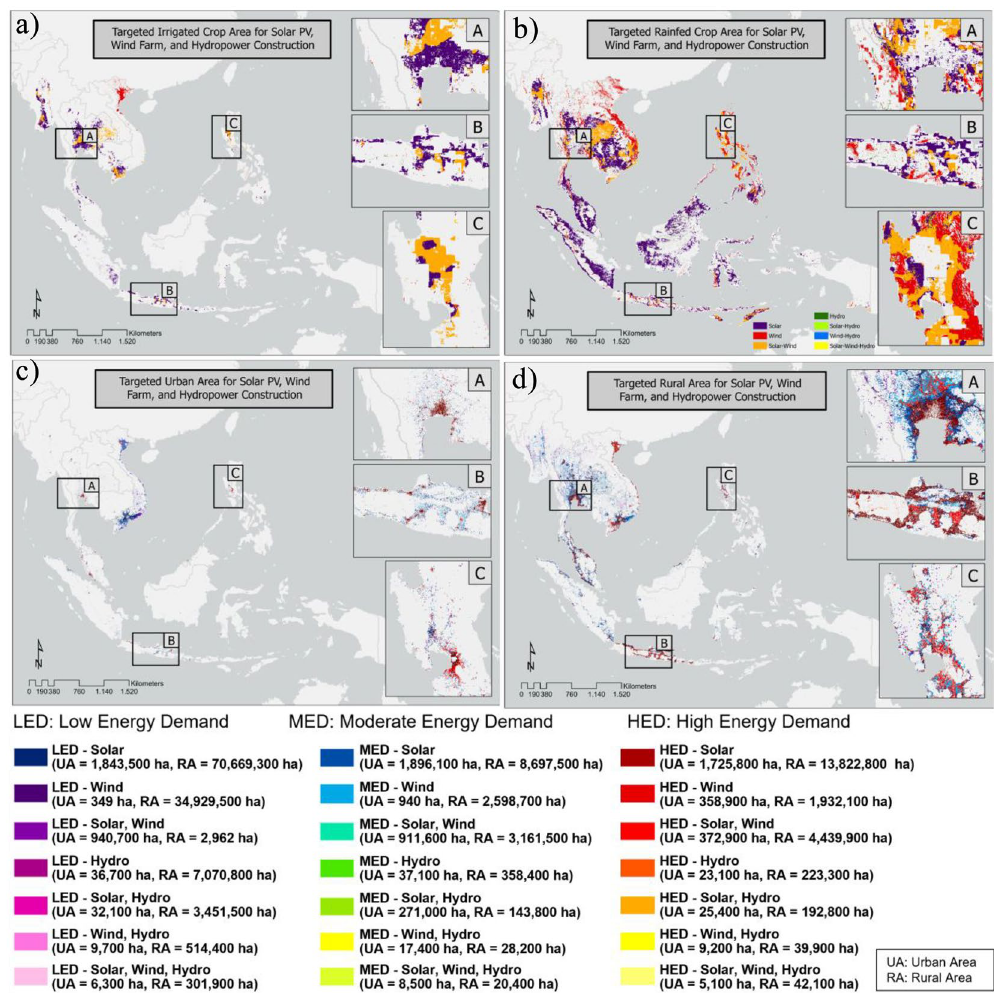
Figure 7. Demands for multi-renewable energy in ( a ) irrigated cropland, ( b ) rainfed cropland, ( c ) urban areas, and ( d ) rural areas in Southeast Asia. The total area of the three groups was calculated both for urban and rural areas.